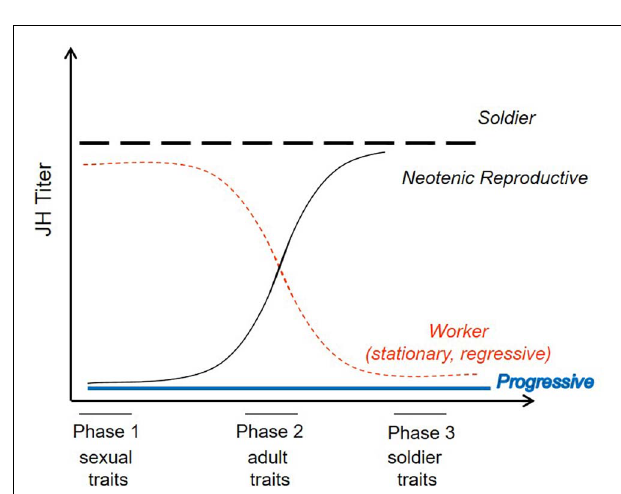
FIGURE 2 | Model proposed by Nijhout and Wheeler (1982) to explain the endocrine regulation of molting types in termites. JH titers during three sensitive periods (phases) between two consecutive molts determine the subsequent molting type of a termite worker. Continuously high or low titers result, respectively, in presoldier/soldier differentiation or progressive development toward winged imagoes. Titers that vary during the intermolt period account for neotenic and continued worker development. For further information, see text. Adapted from Nijhout and Wheeler